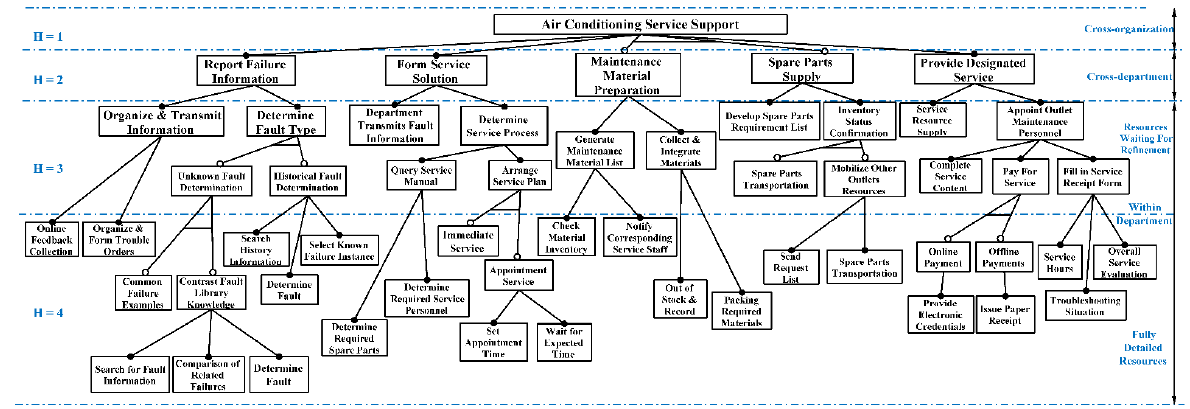
Figure 4. Air-conditioning service support FM H .